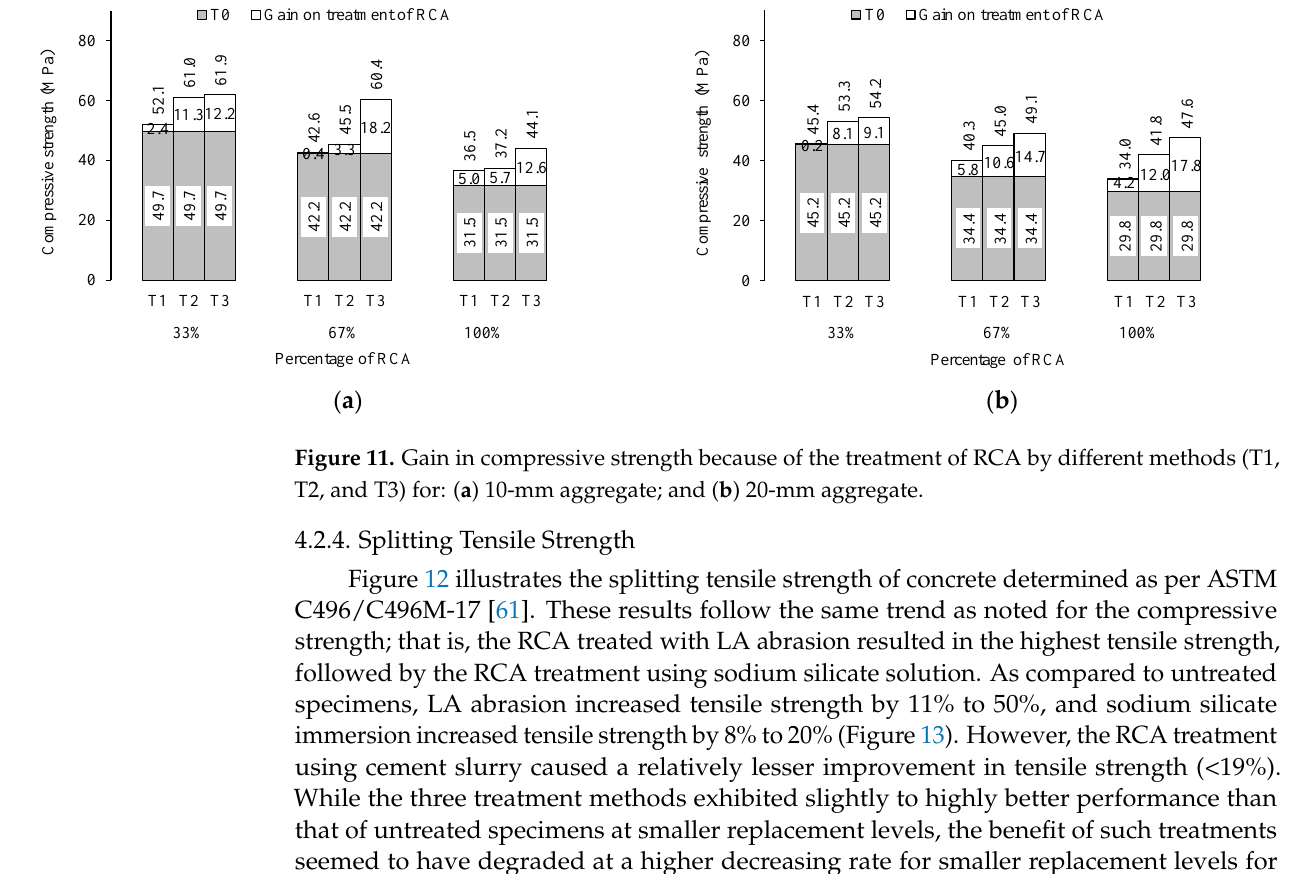
Figure 10. Compressive strength results of untreated and treated RCA for: ( a ) 10 mm aggregate; and ( b ) 20 mm aggregate.